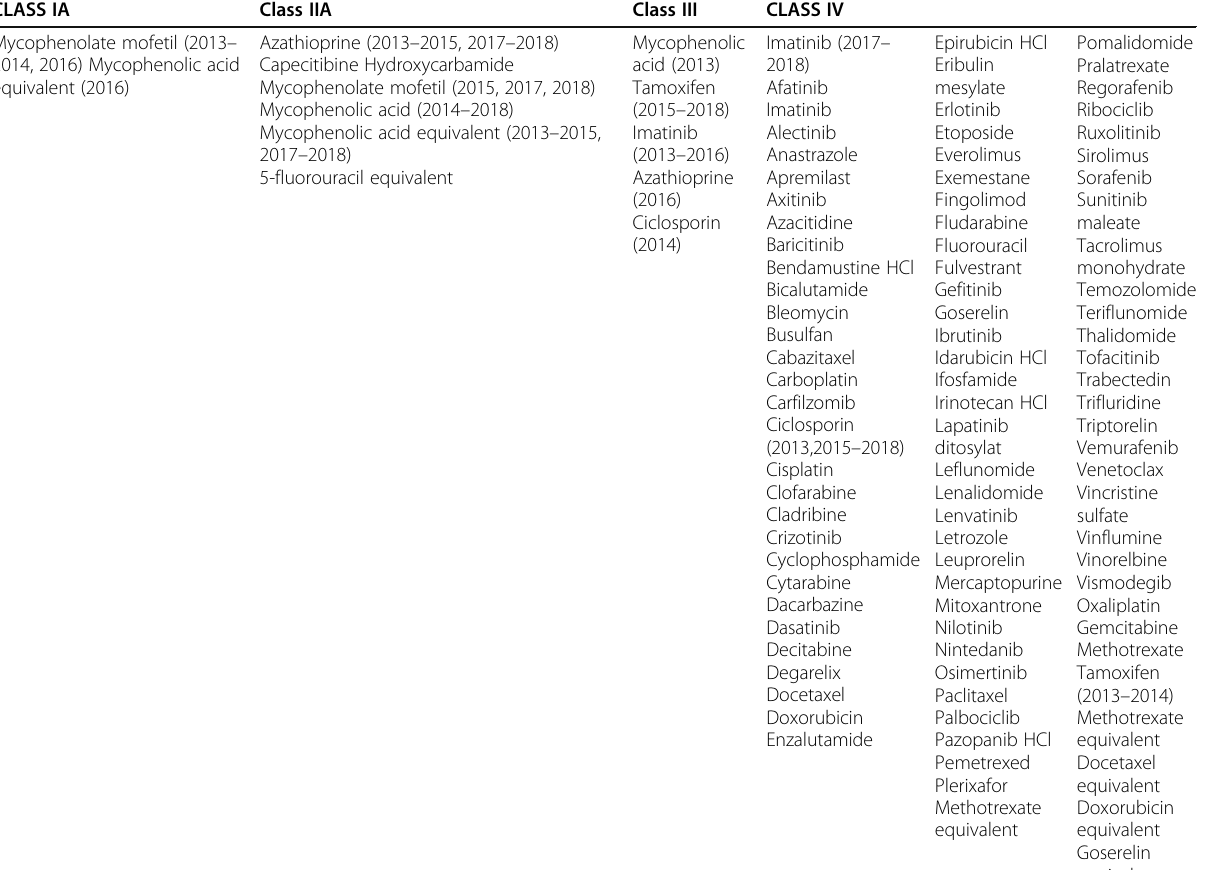
Table 3 Risk categorization of chemotherapeutic drugs based on environmental exposure data between 2013 and